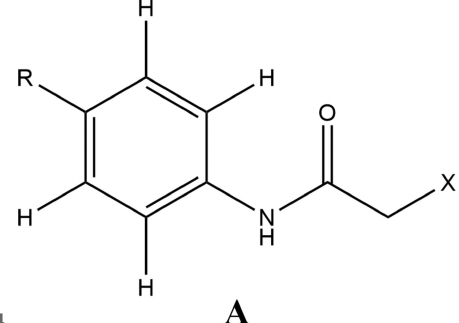
Figure 4 Fragment A used in the Cambridge Structural Database